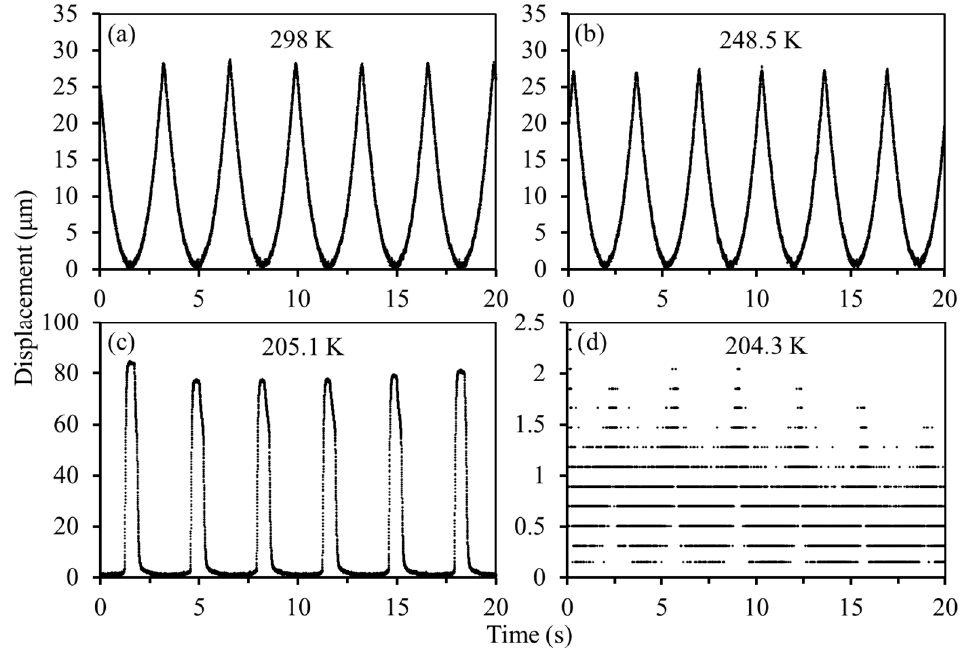
Figure 7. Recorded displacements of the comb-drive actuator with small spring constant at different temperatures: ( a ) 298 K; ( b ) 248.5 K; ( c ) 205.1 K; ( d ) 204.3 K.